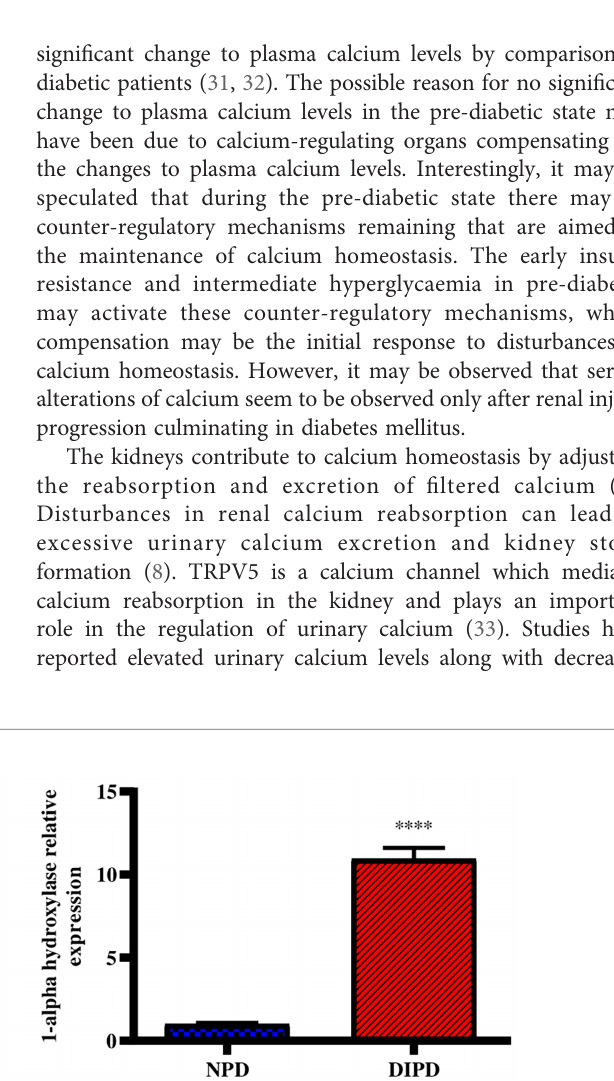
FIGURE 3 | Evaluation of bone turnover through plasma osteocalcin and urine deoxypyridinoline concentrations in the non-pre-diabetic (NPD) group and diet- induced pre-diabetic (DIPD) group (n=6, per group).Values are presented as mean ± SEM. ***=p < 0.001, ****=p < 0.0001 by comparison